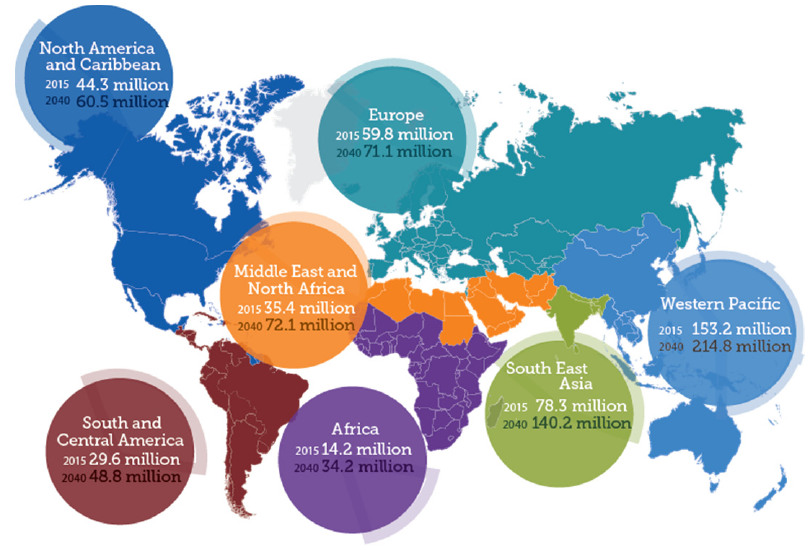
Figure 1. World map of diabetic retinopathy [9].